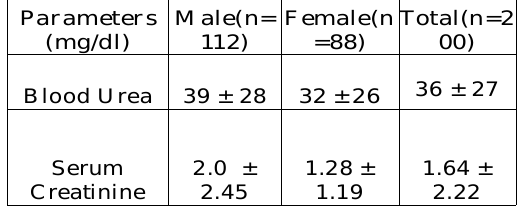
Table 2: Renal Function Test (RFT) in Type II DM